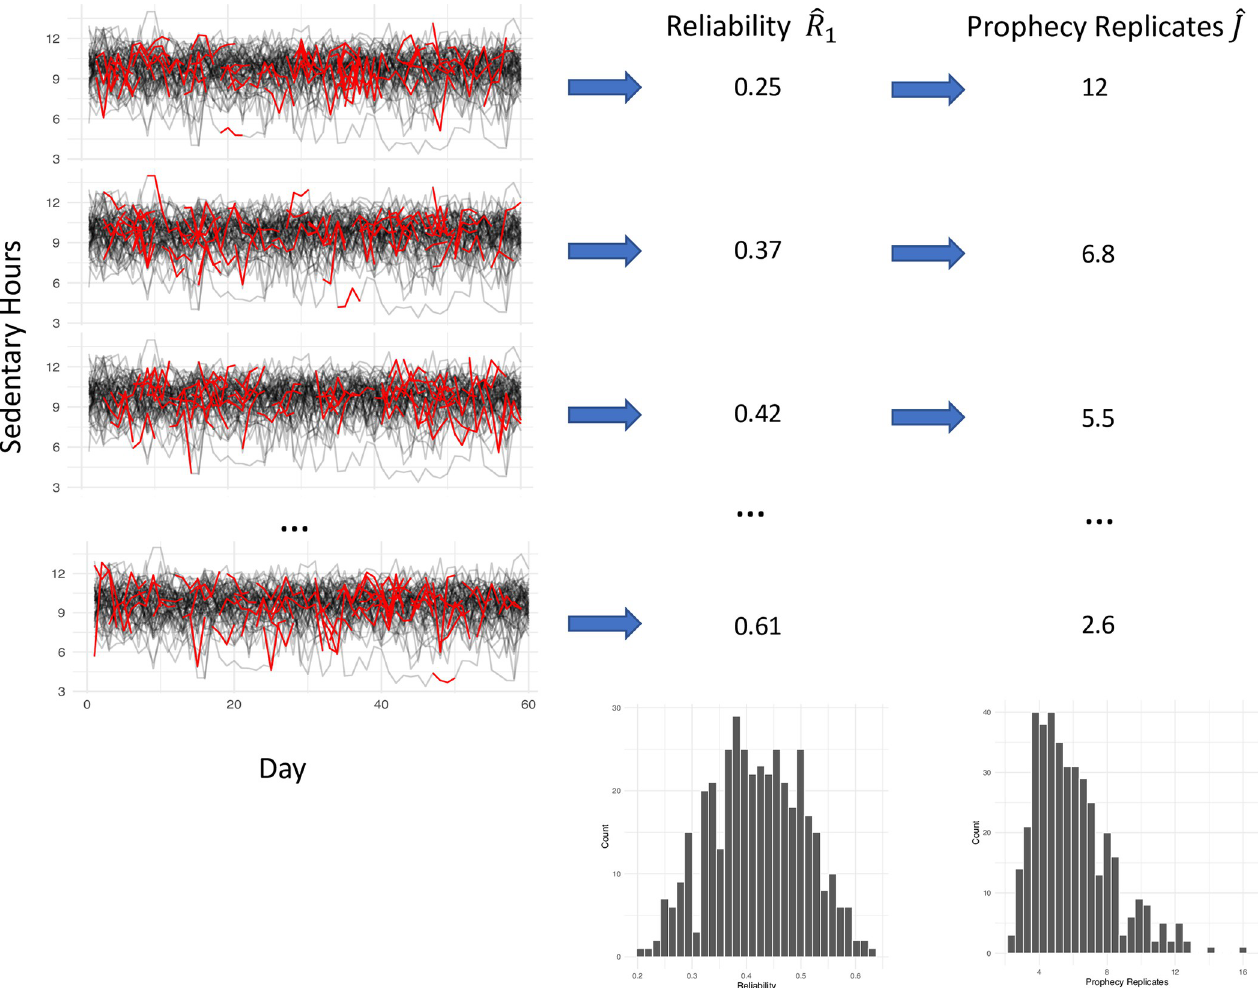
Fig 1. Framework for creating sampled datasets. Each row represents a single sampled dataset. The left column contains all of the observed activity trajectories in the motivating data, with the red segments representing the selection of days J which were selected for a given sample. The second column shows the estimated reliability ^ R ^ based on the previous selection of days. The final column shows the subsequent prophecy estimate of the number of replicates ^ J ^ 1 required to achieve a reliability of 0.8. The histograms at the bottom of the second and third columns represent the distributions of ^ R ^ samples generated in this